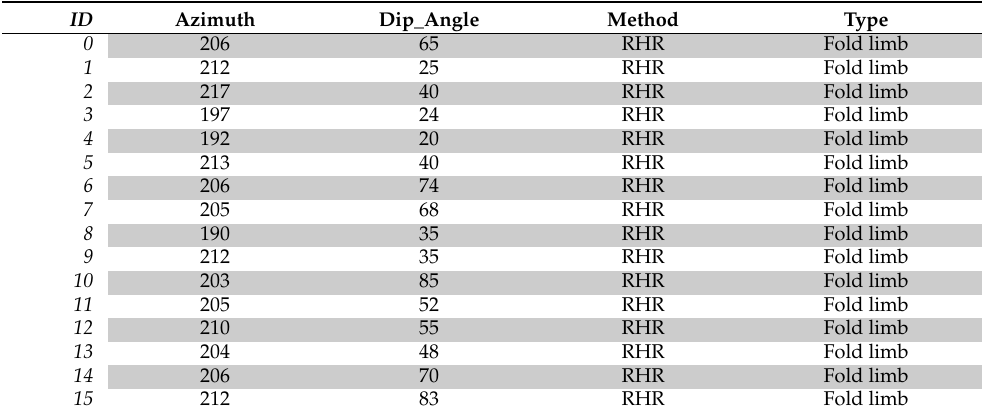
Table A1. Macduff dataset without any data differentiation evidenced by the field investigator (i.e., all data is labelled as generic ‘Fold